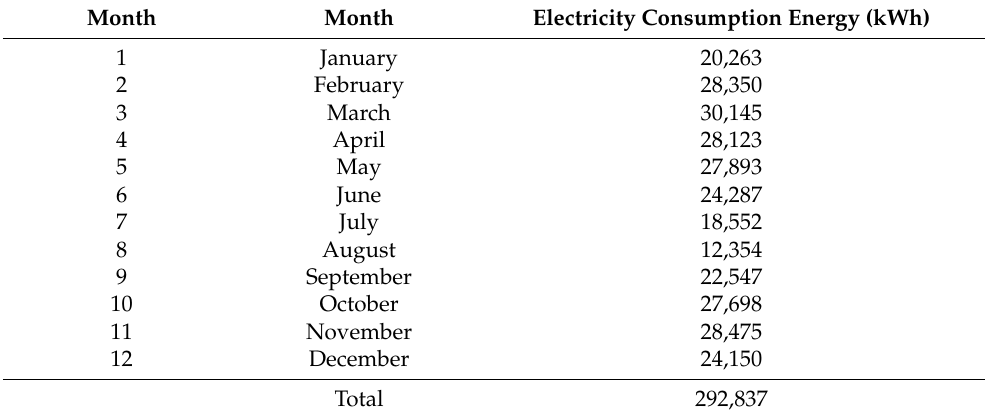
Table 2. Presentation of electrical energy consumption by month in 2021.